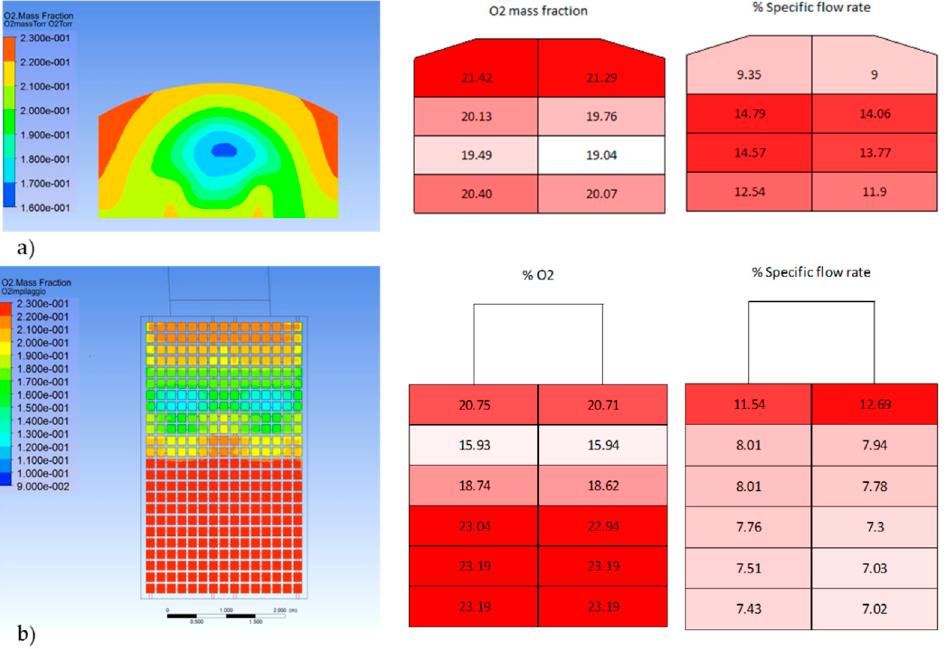
Figure 14. O 2 mass fraction and specific flow rate for 20% WGR—( a ) port neck section ( b ) checkers section.